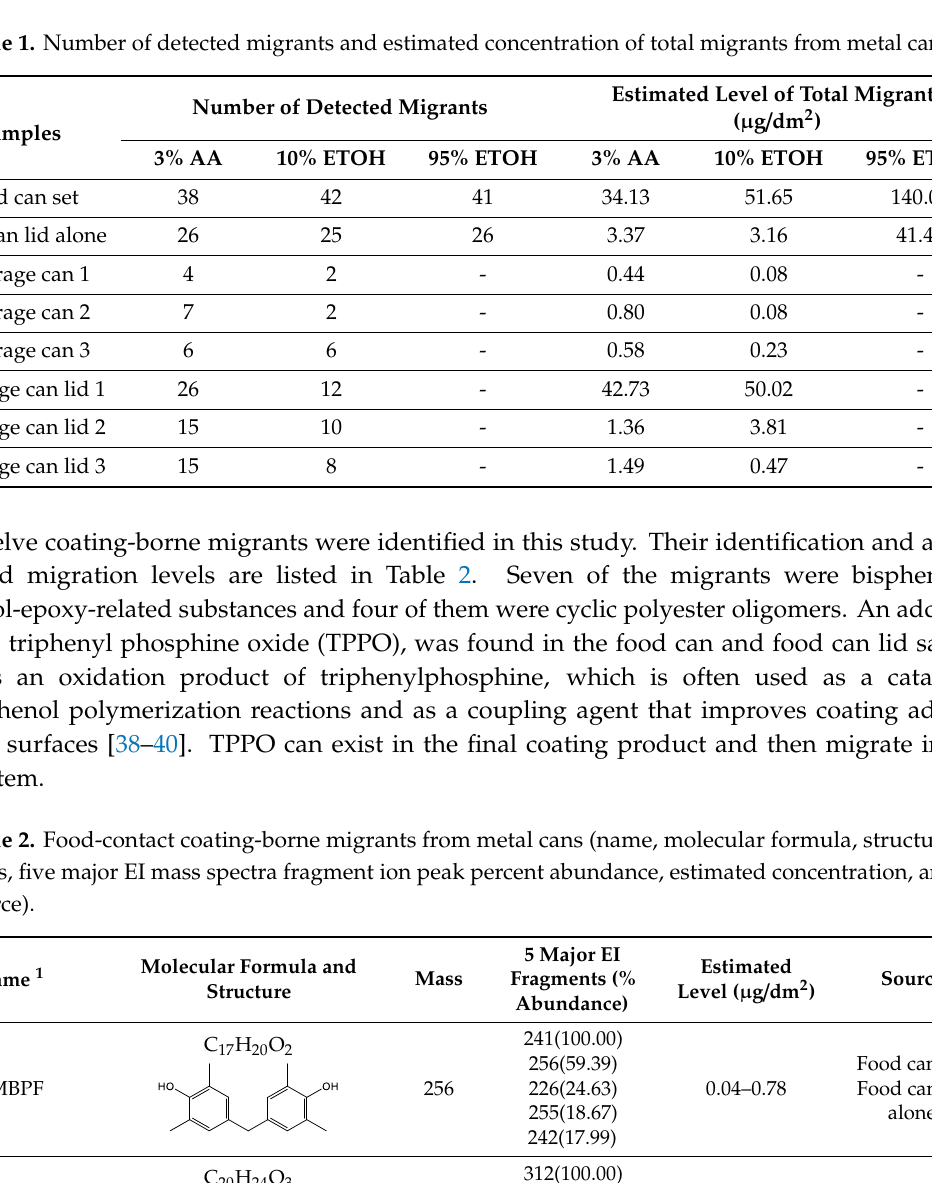
Table 1. Number of detected migrants and estimated concentration of total migrants from metal cans.